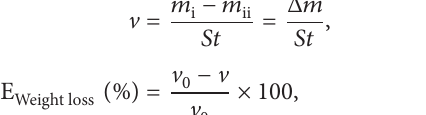
Figure 3: Potentiodynamic polarization curves at 300 K for carbon steel in 0.5 M HCl in the absence and presence of different concen- trations of